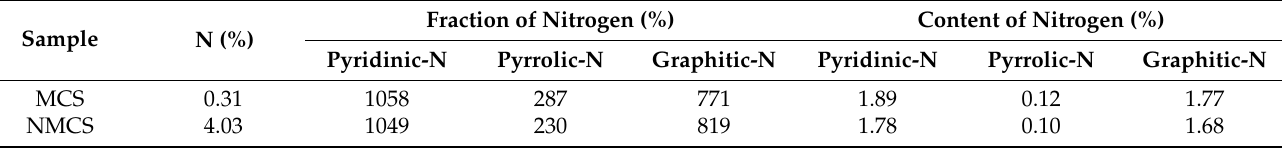
Table 2. Nitrogen content of MCS and